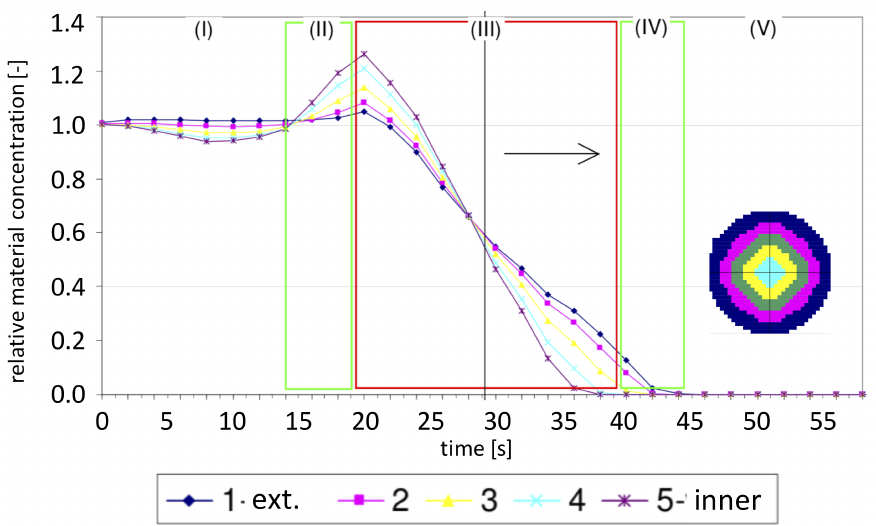
Figure 11. Diagram of ECT data changes over time during silo discharge. The five distinct linear plots show the average material concentration for five concentric rings from 1 (for the most external ring) to 5 (for the innermost circle). There are five stages in the process, indicated ( I – V ) in the upper part of the